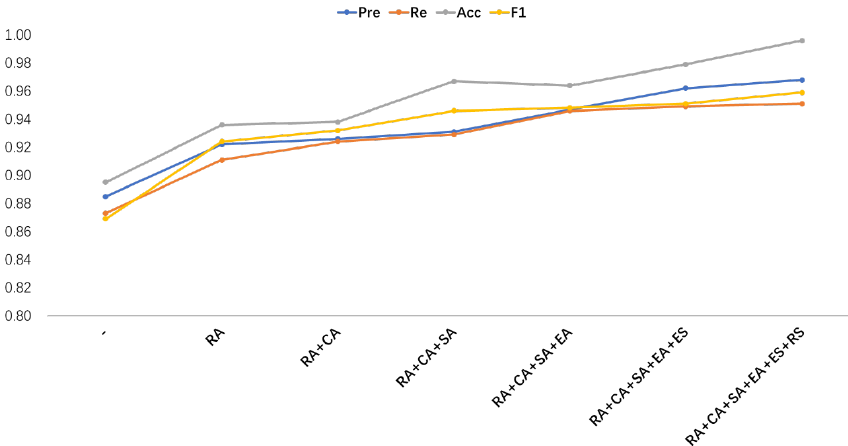
Figure 11. The performance of four metrics, Pre, Re, Acc, and F1 in the ablation experiment. The “-” means the model using no significant components, and the “+” indicates the model with multiple components integrated until the complete SEAGNET model is reached on the far right.